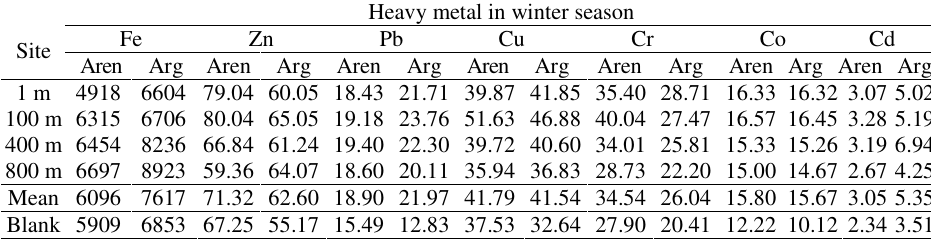
Table 6. Average heavy metal concentrations in ppm from different fractions of sediments in winter season along stream flow in the investigated area in addition to blank sample.